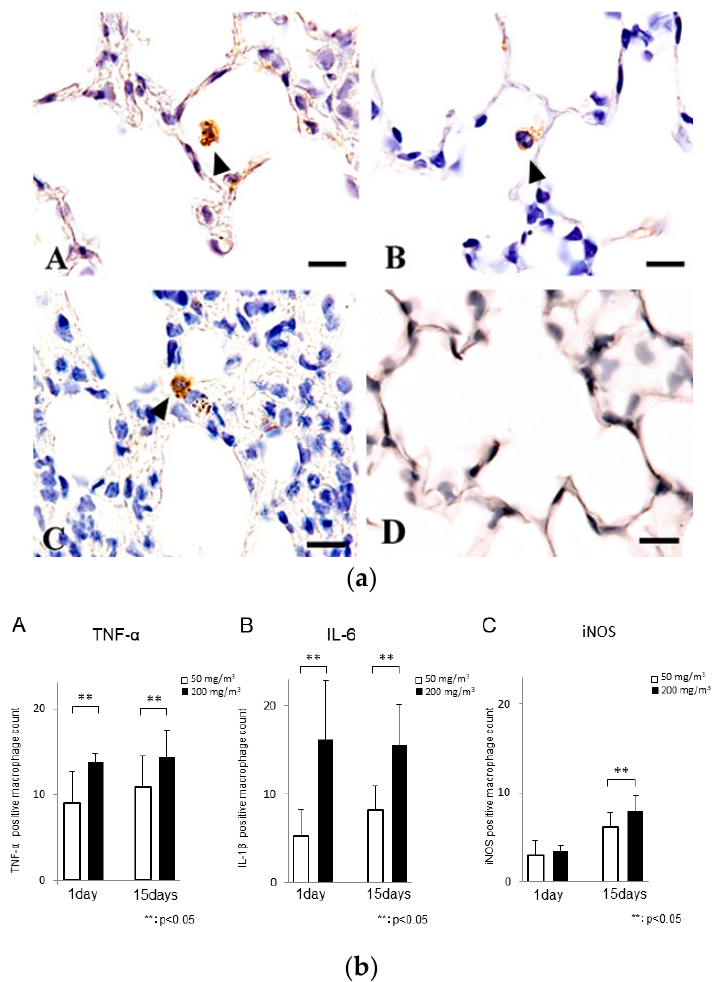
Figure 7. ( a ) TNF- α (A), IL-6 (B), and iNOS (C) immunohistochemistry of the lungs of mice treated with 50 mg/m 3 of the powder for one day. Macrophages containing the brown particles show positive immunoreactivity for TNF- α , IL-6, and iNOS (black arrowheads). Control (lungs of mice with no treatment, TNF- α ) (D). Bars = 10 µ m. ( b ) A semi-quantative analysis of the immunohistochemical reactions (A: TNF- α , B: IL-6, C: iNOS) in the lungs of mice treated with 50 mg/m 3 (open bars) and 200 mg/m 3 (filled bars) of the powder for one day and for 15 days (** p < 0.05).